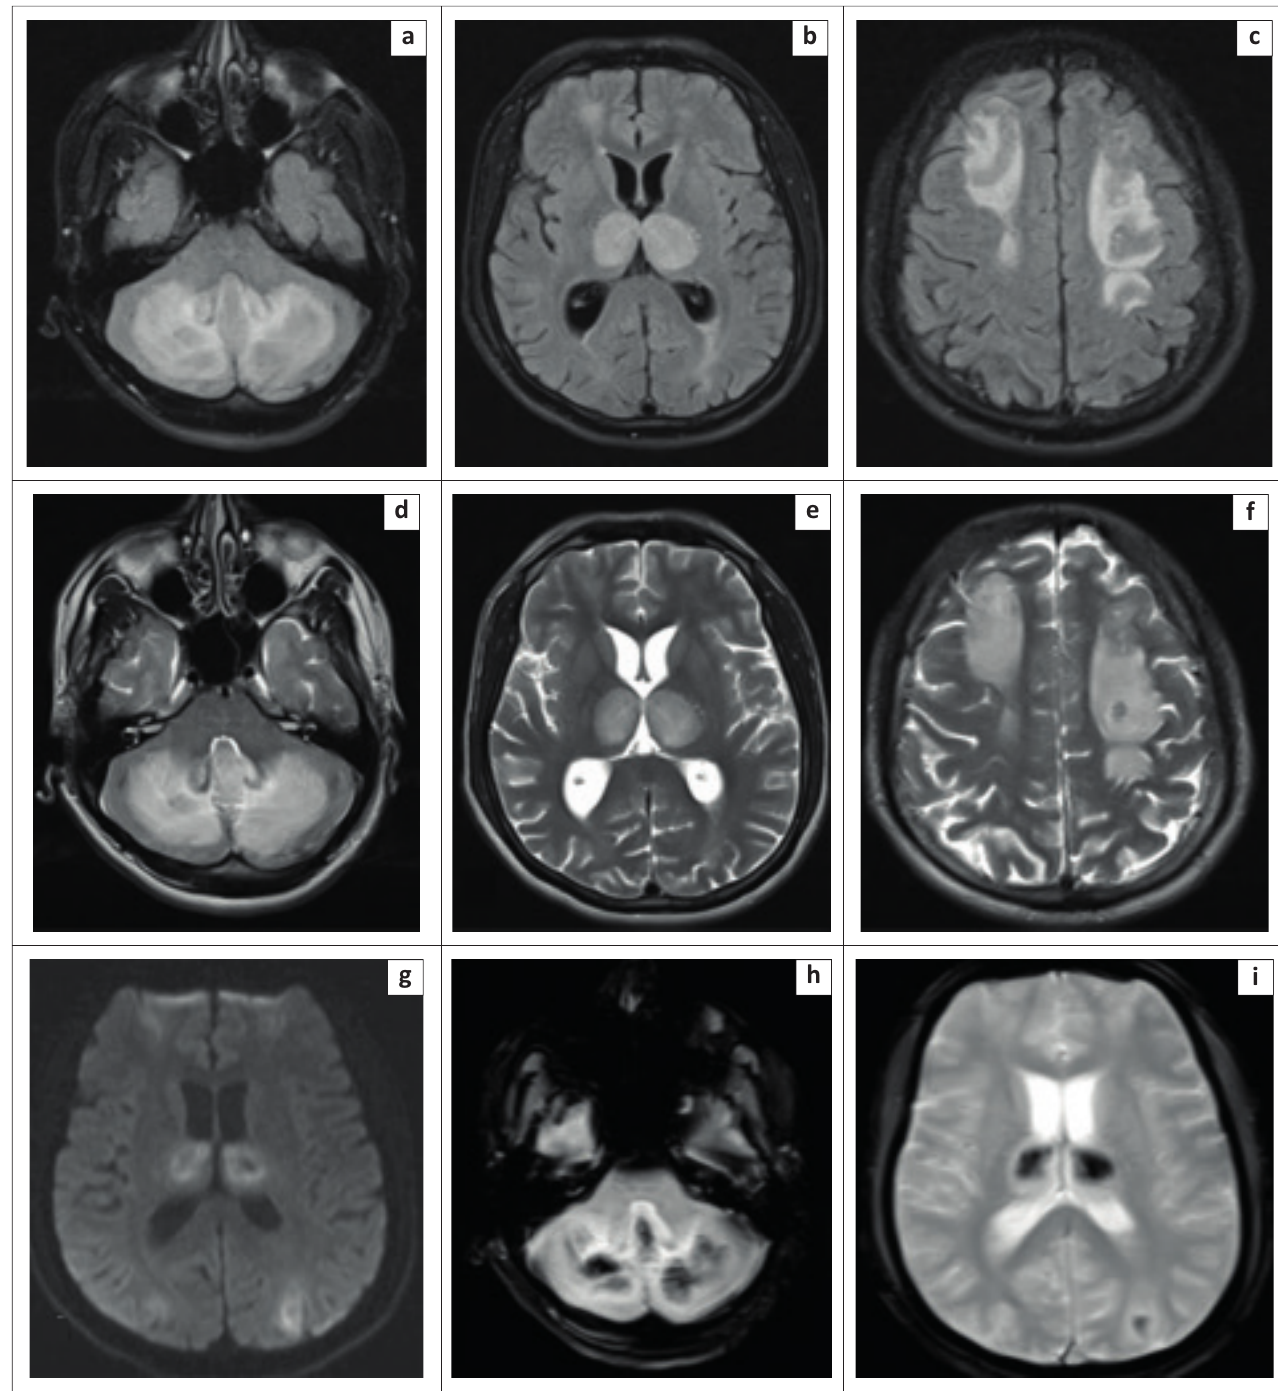
FIGURE 2: [Case 1]: Brain MRI in a 25-year-old male diagnosed with dengue infection indicates symmetric FLAIR (a-c) and T2 hyperintense areas of altered signal intensity in the vermis, bilateral cerebellar hemispheres, thalami and bifrontal and biparietal white matter (d-f) with patchy diffusion restriction at DWI (g) – ADC not presented. Areas of blooming on GRE images (h, i), representing haemorrhages, are